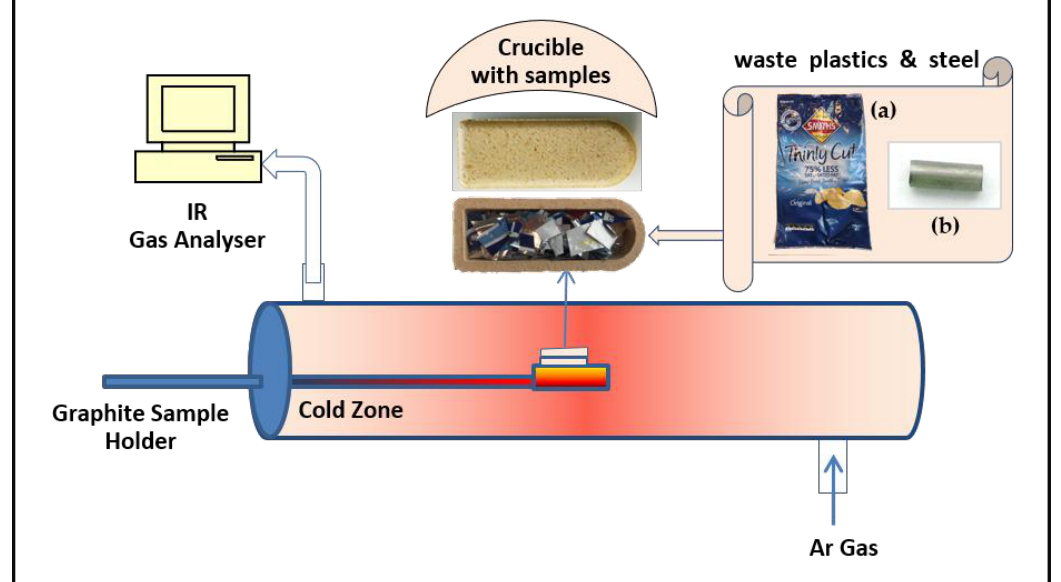
Figure 1. Schematic representation of carburization experiment.